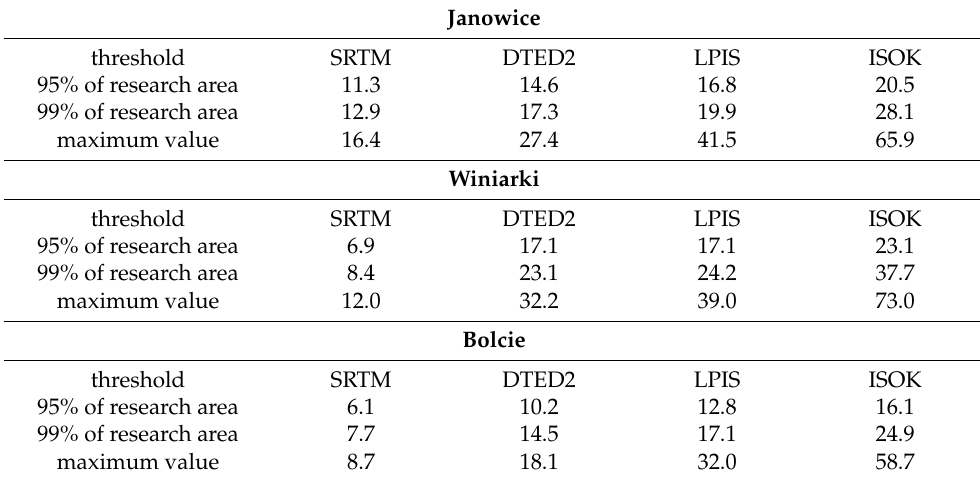
Table 8. Comparison of the range of the slope values and the slope maximum threshold values ( ◦ ) for 95% and 99% of pixels in the research areas.